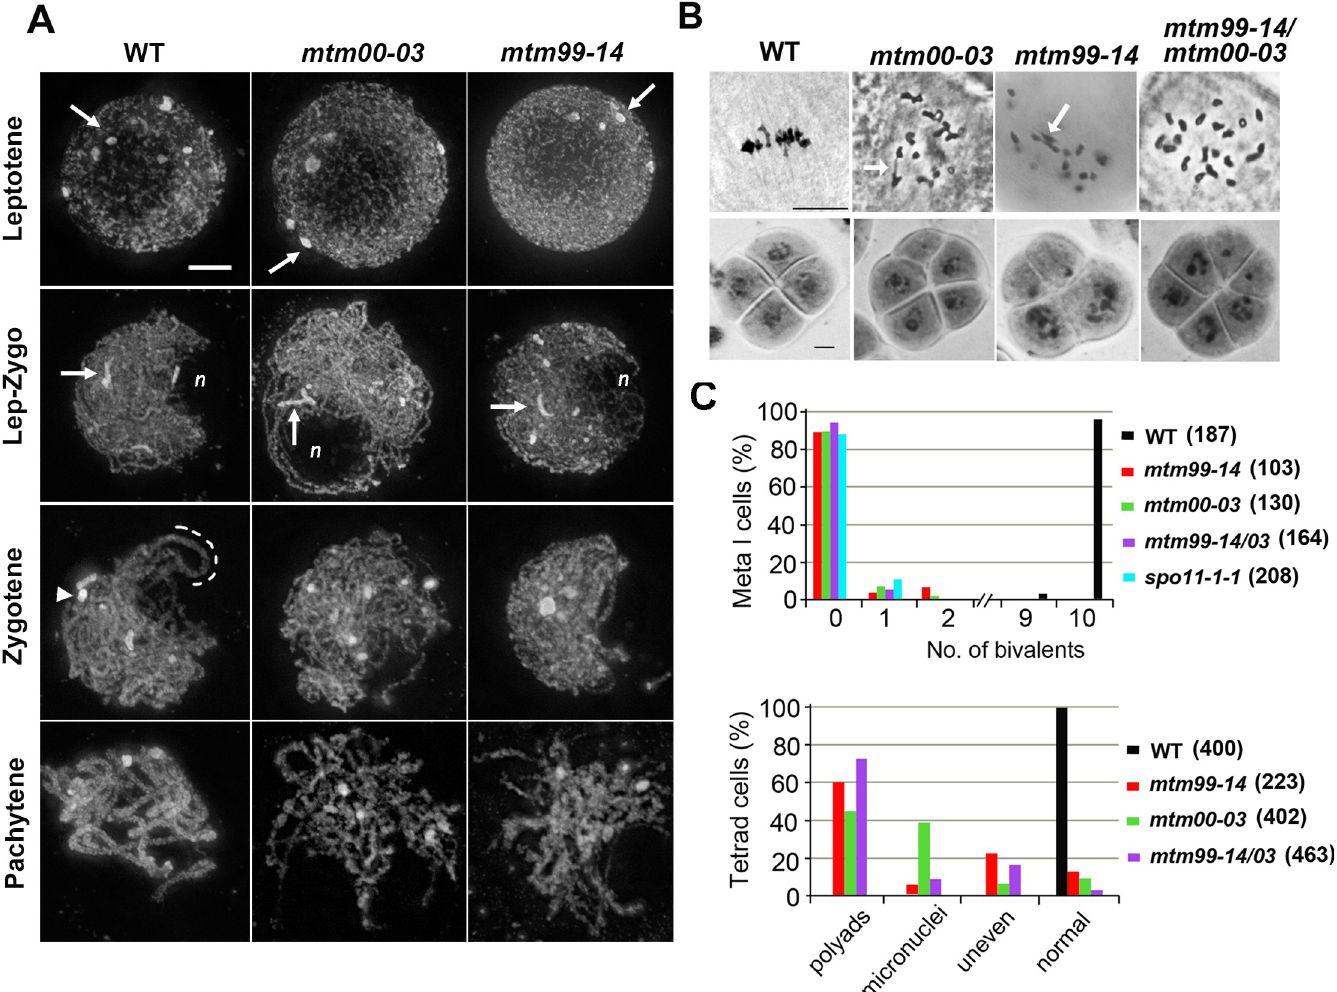
Fig 1. mtm99-14 and mtm00-03 are allelic mutants with defective meiosis. (A) Projected images of WT and mutant meiocytes stained with DAPI during early prophase I. Initially spherical heterochromatic knobs (arrows) become elongated at the leptotene-zygotene transition that accompanies a positional change of the nucleolus ( n ) from the nuclear interior to the periphery. At zygotene, paired knobs (arrowhead) and chromosomes (dashed line) were observed in WT. An obvious aberrant phenotype of both mutants was observed during the pachytene stage, manifested as fluffy chromosomes. Scale bar represents 5 μ m. (B) Acetocarmine staining of male meiocytes during the metaphase I (upper panel) and tetrad stages (lower panel) of WT, mtm00-03 , mtm99-14 , and heteroallelic mtm99-14/mtm00-03 plants. In WT male meiocytes, ten bivalents are aligned on a metaphase I plate and later produce normal tetrad cells. Mutant cells mainly present univalents and rare interconnected chromosomes counted as bivalents (arrows). Scale bar represents 10 μ m. (C) Quantitative results of meiotic phenotypes during the metaphase I and tetrad stages. Numbers of cells analyzed are shown in parentheses. The spo11-1-1 is another mutant allele (see next section).